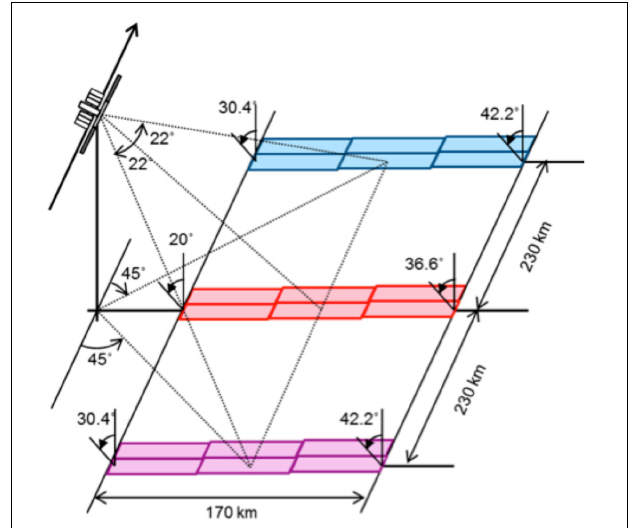
FIGURE 1 | SEASTAR observation geometry.